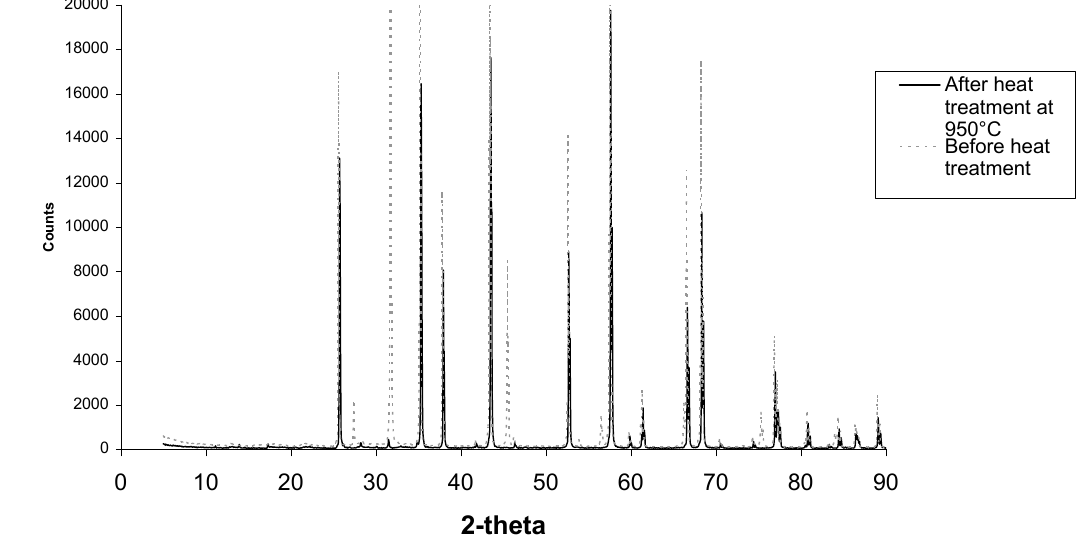
Figure 10. XRD scan of alumina samples before and after heat treatment showing common corundum phases and halite phases that are no longer present after heat treatment. New small peaks are present between 20 and